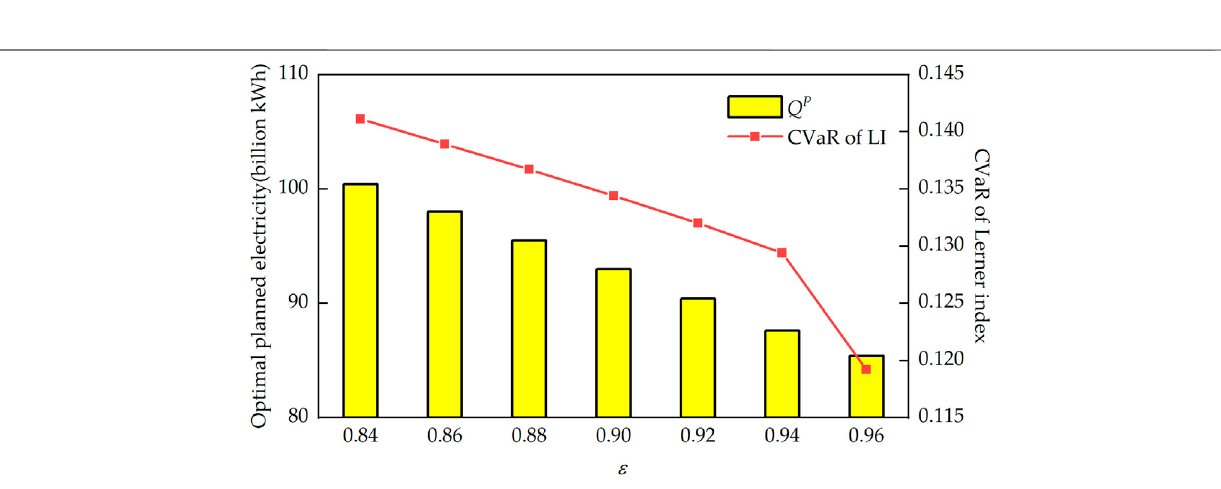
FIGURE 8 | Optimal allocation of planned electricity under different risk aversion degrees of GCs.